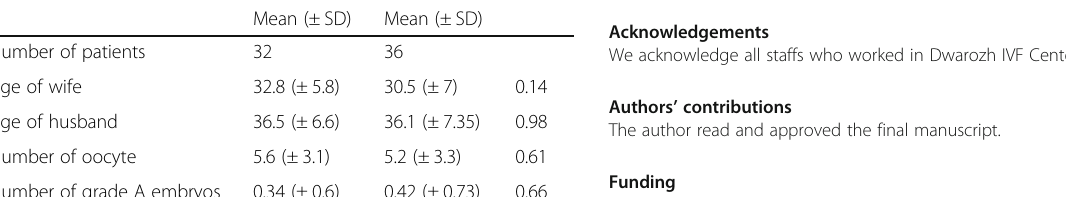
Table 3 Comparison between fresh and frozen-thawed non- obstructive azoospermia group regarding different criteria and outcomes Variables Fresh NOA Frozen NOA Number of patients